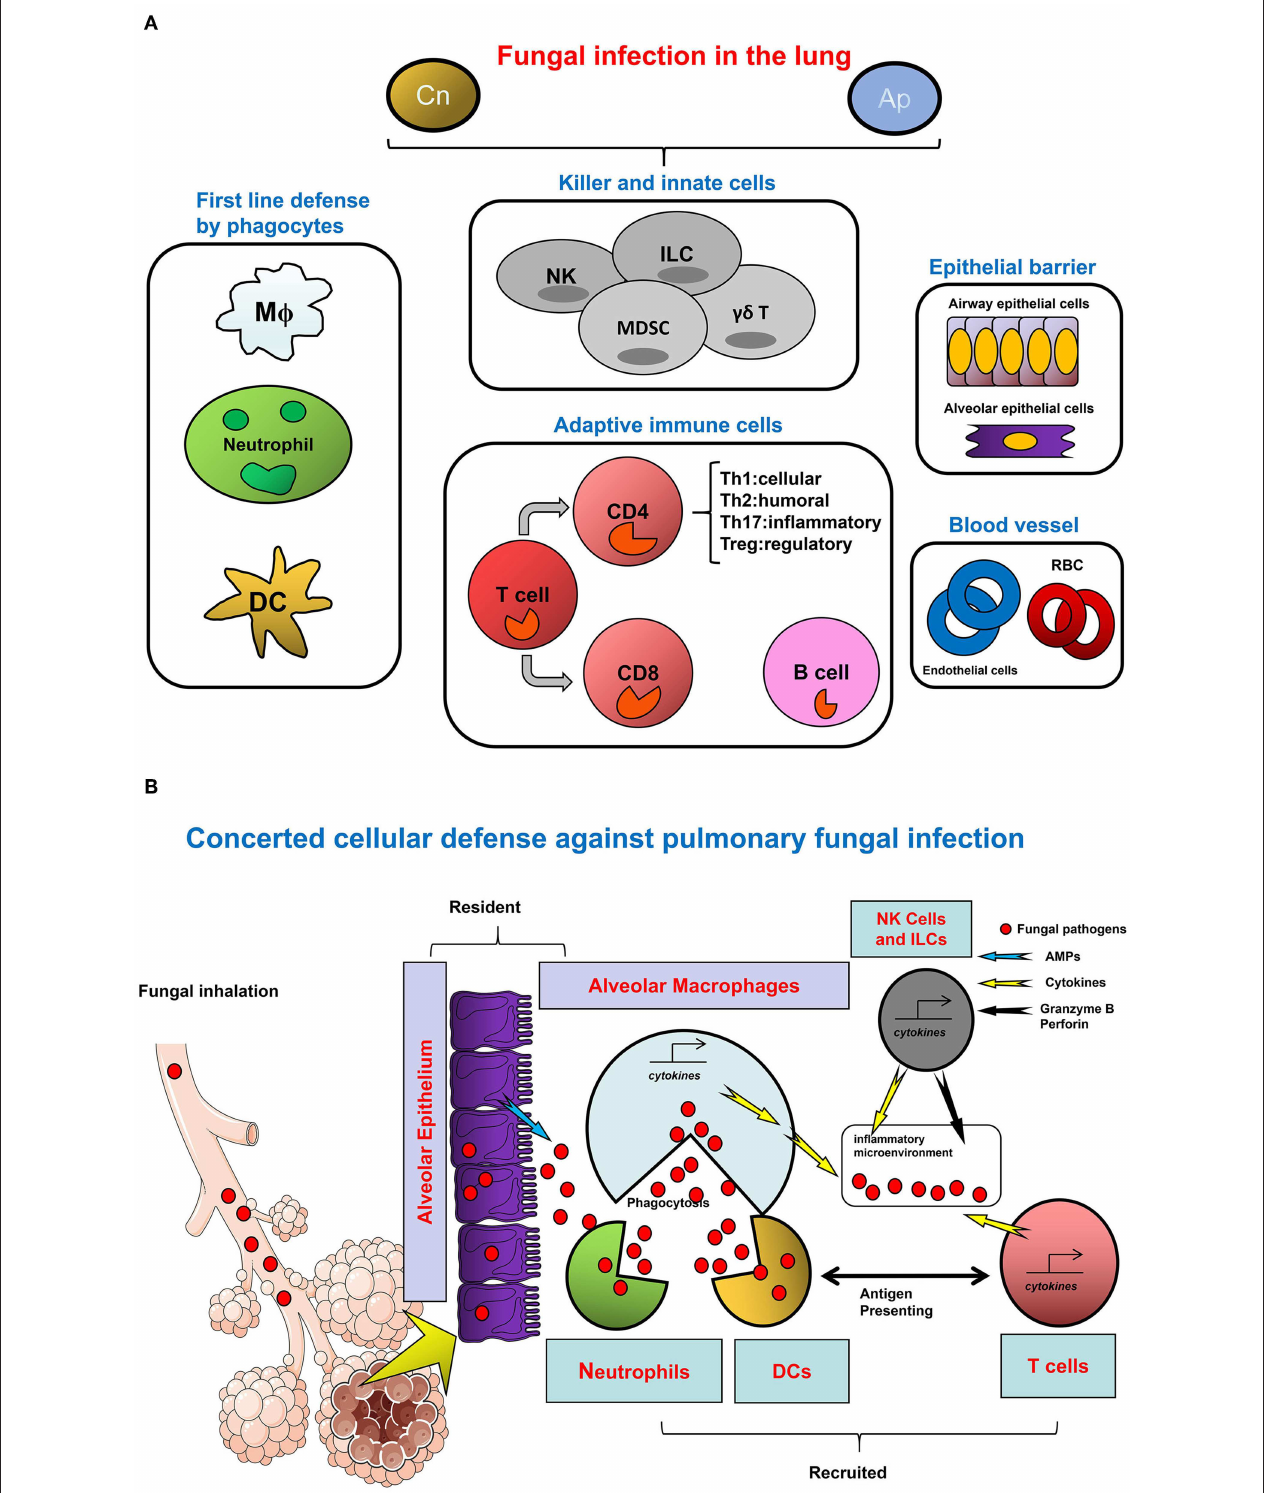
FIGURE 3 | The Network of cellular defense against fungal infections in the lung. (A) The cell category in host response to infection. (B) Divergent cell types orchestrate the host defense against fungal infection. To defend against pulmonary fungal infection as represented by Cn and Ap, divergent types of cells are involved